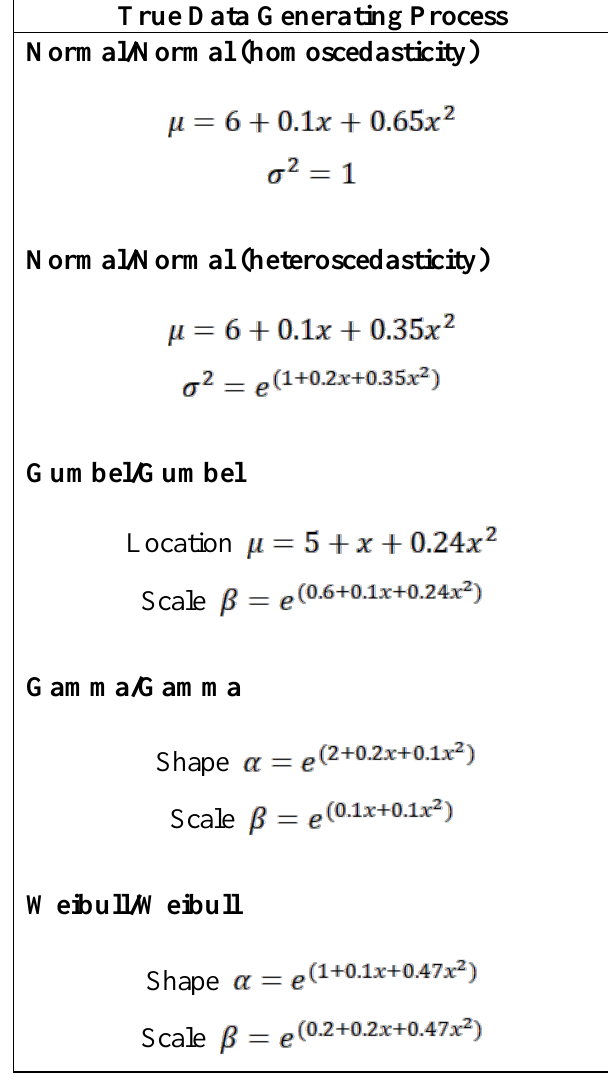
Table A2. Simulation process: conditional